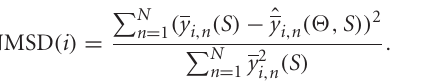
CV model responses of channels 1, 3, 6, and 8 when the stimulating channel is L2. (C) Normalized mean-squared difference in each channel when the stimulating channel is L1. (D) Relative root mean-squared energy in each channel when the stimulating channel is L2. (E) Normalized mean-squared difference in each channel when the stimulating channel is L1. (F) Relative root mean-squared energy in each channel with the stimulating channel is